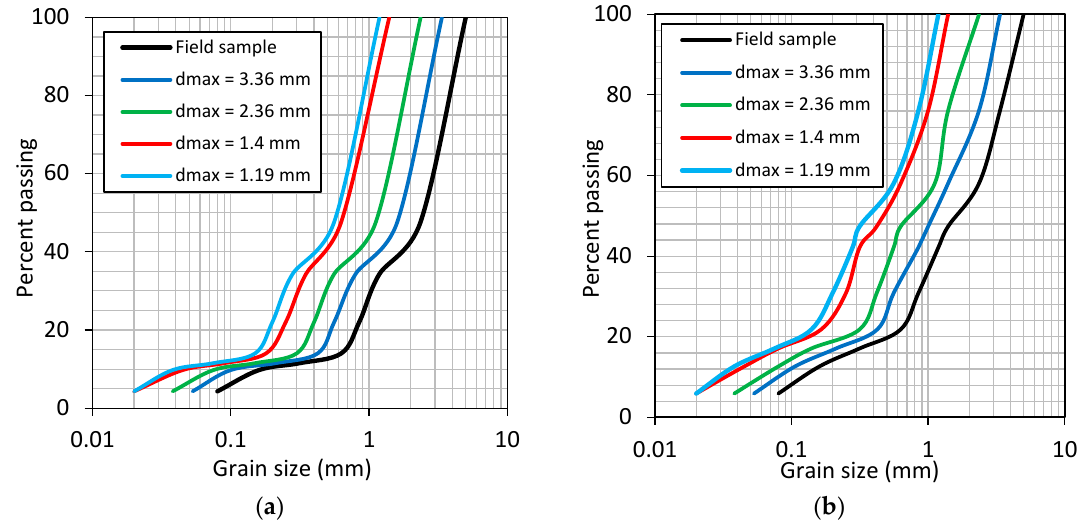
Figure 4. PSDCs of the field sample and parallel samples with different d max values for: ( a ) M1 and M3; ( b ) M2.